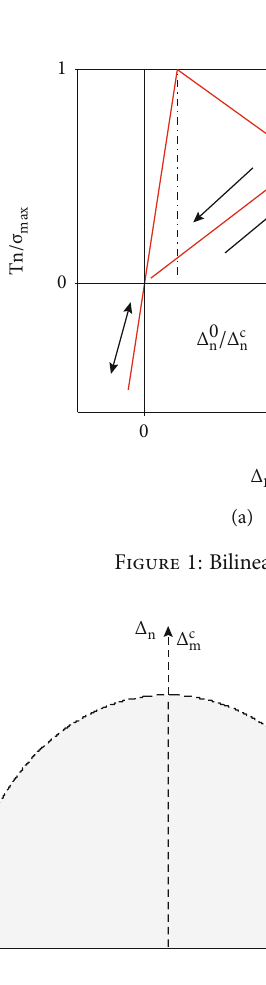
Figure 2: Exact functional boundary of the bilinear CZM in ABAQUS (compression in not